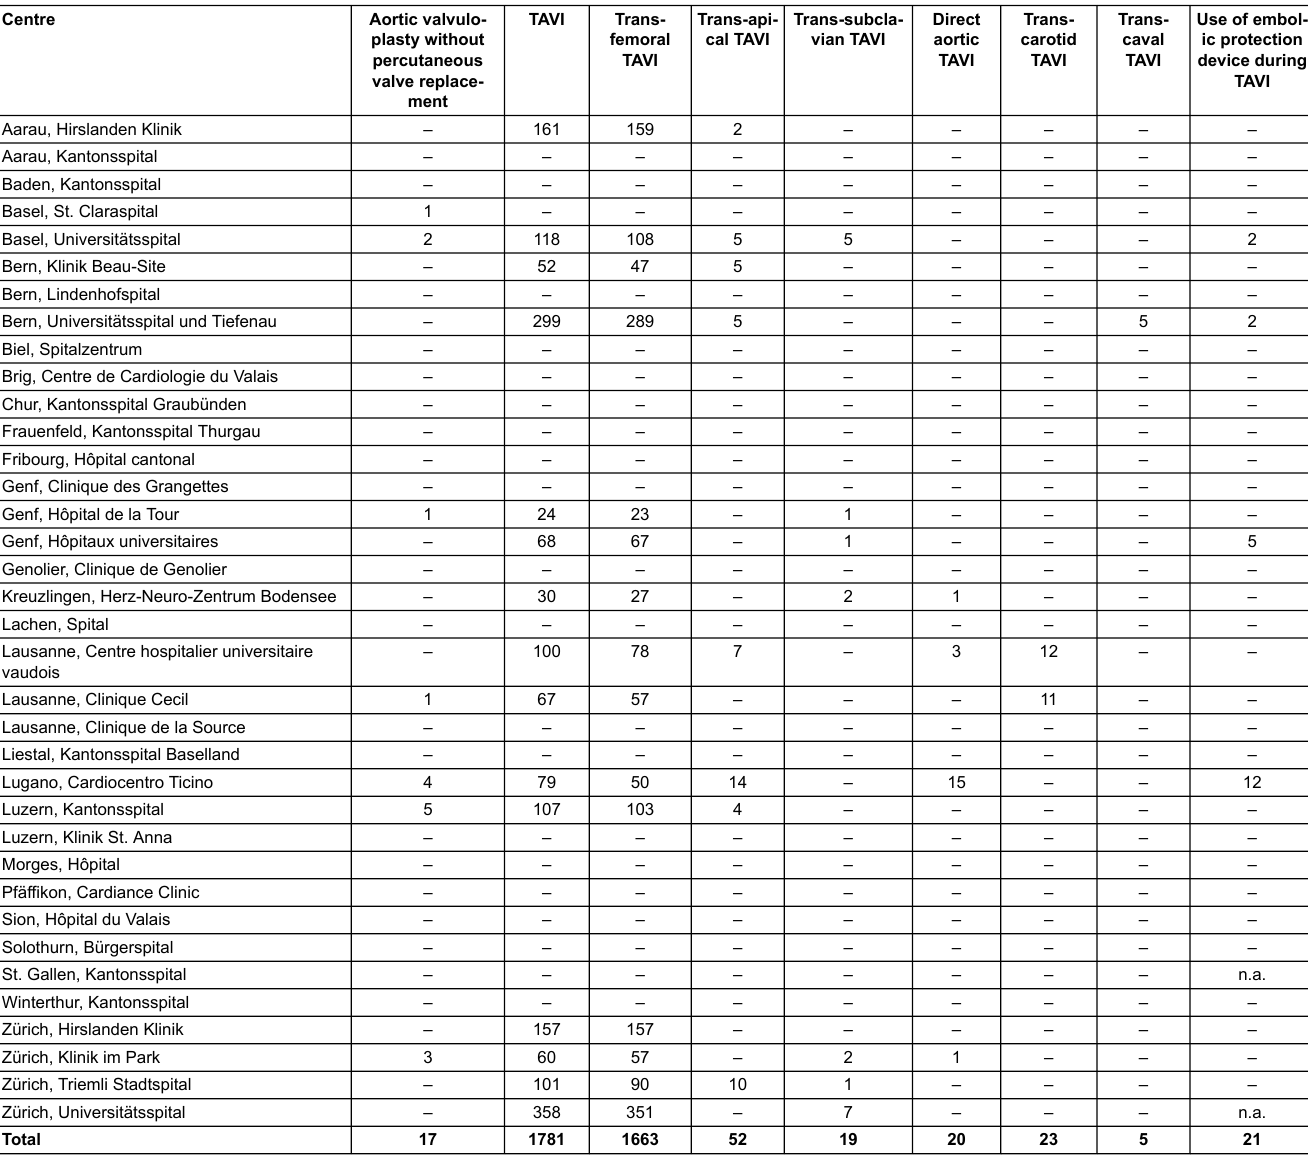
Table 5: Structural interventions: aortic valve. Centre Aortic valvulo-